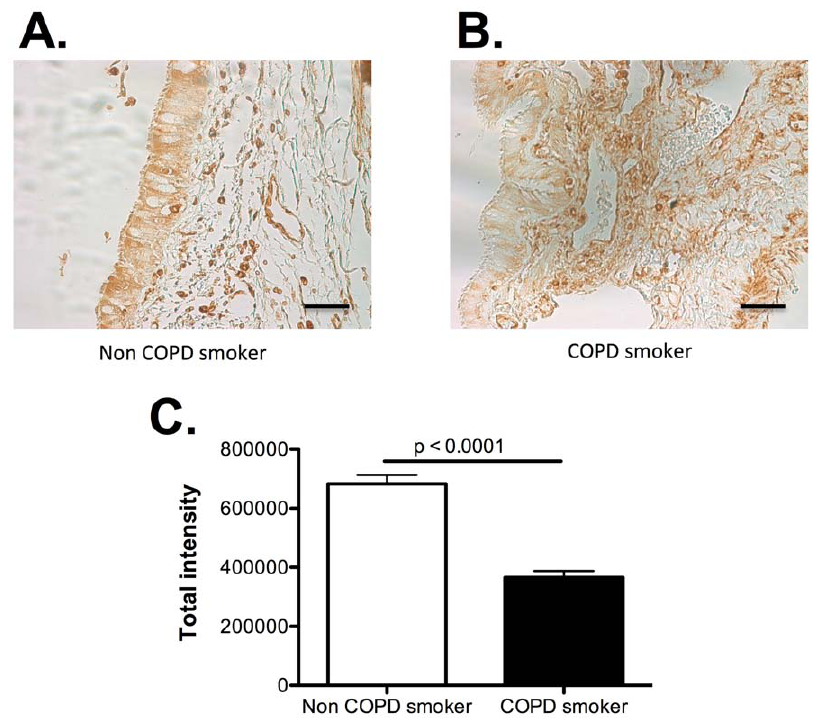
Figure 1. FABP5 expression is decreased in COPD airway epithelial cells. A. Immunostaining of FABP5 protein (brown color) in airway epithelial cells from normal smoker. Bar represent 50 m m. B. Immunostaining of FABP5 protein (brown color) in airway epithelial cells from